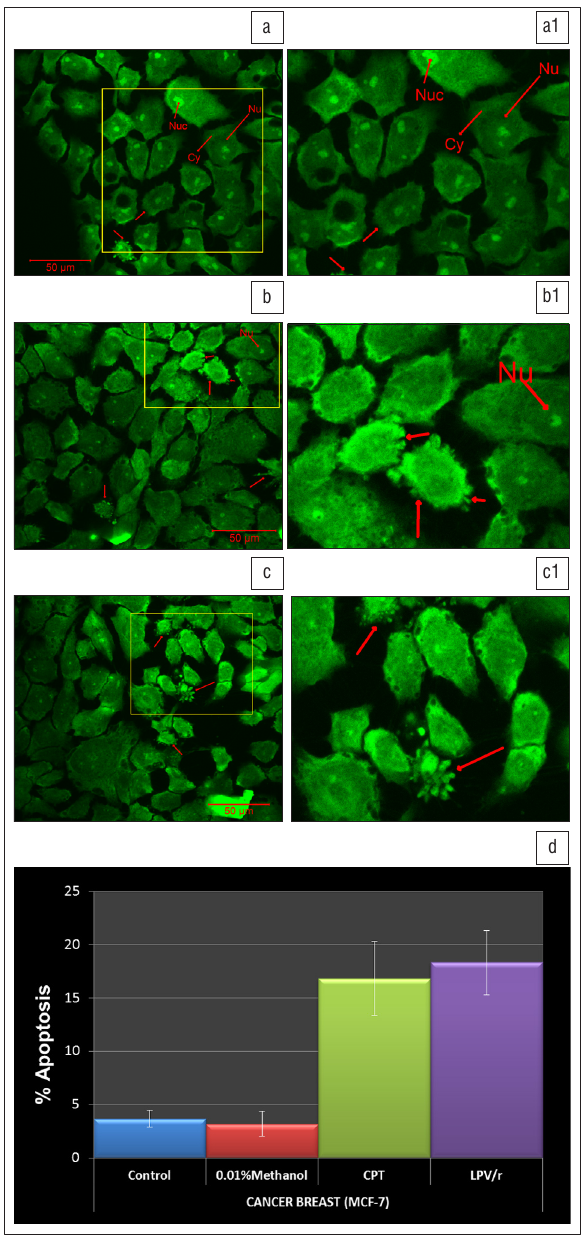
Figure 4: Effects of LPV/r on CPT mediated apoptosis in MCF-7 cells. (a) Untreated control MCF-7 cells. (b) CPT treated MCF-7 cells. MCF-7 cells were stimulated with 1 µM CPT for 6 h without prior exposure to LPV/r. (c) MCF-7 cells incubated with LPV/r prior to apoptosis induction. Apoptosis was assessed using acridine orange staining. Arrows point to apoptotic bodies and cells undergoing apoptosis with the characteristic feature of membrane blebbing. Areas within the box are magnified to the right (a1, b1, c1). (d) A total of 600 cells per group was counted from three independent experiments to determine the percentage of apoptotic cells. LPV/r had no significant inhibitory effects on CPT induced apoptosis in MCF-7